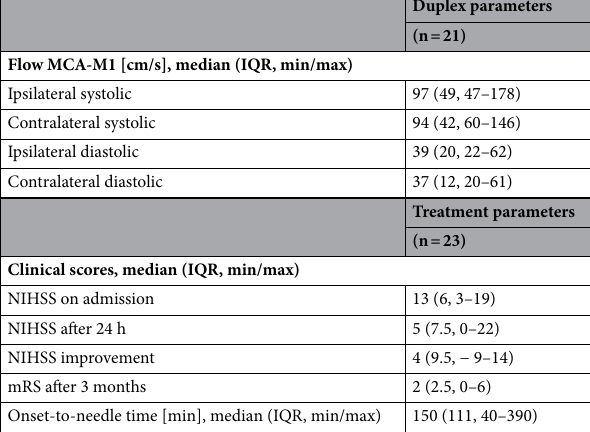
Duplex parameters (n = 21)